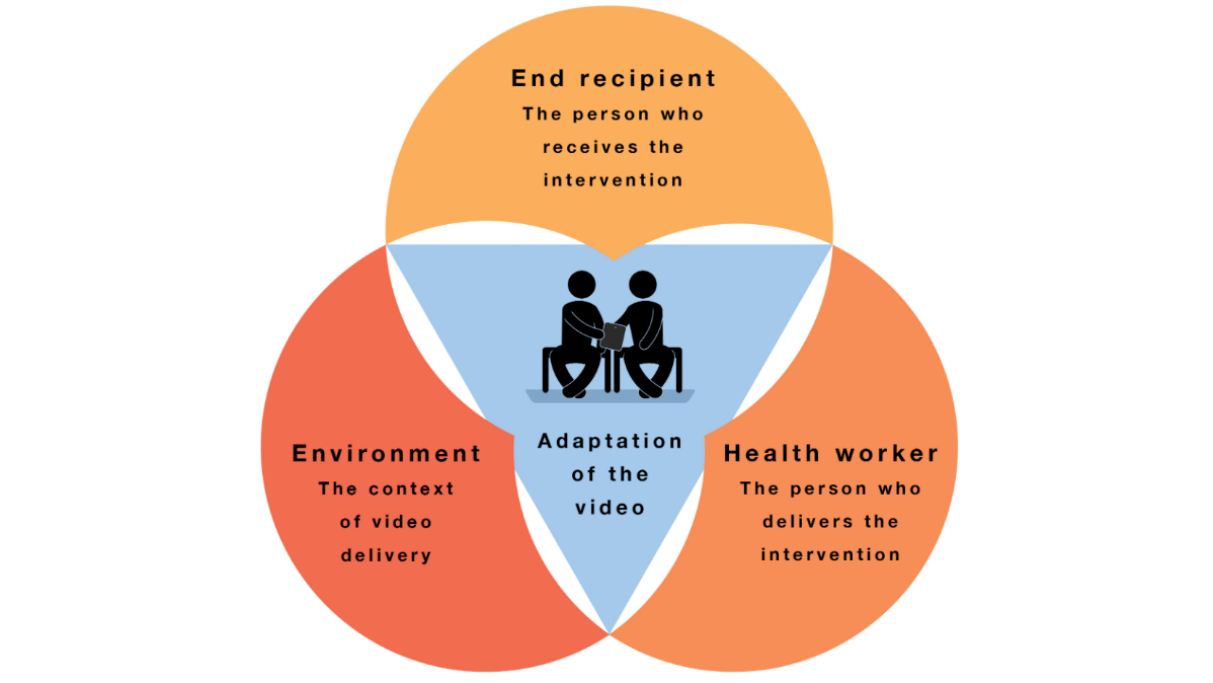
Figure 1. The Video Adaptation